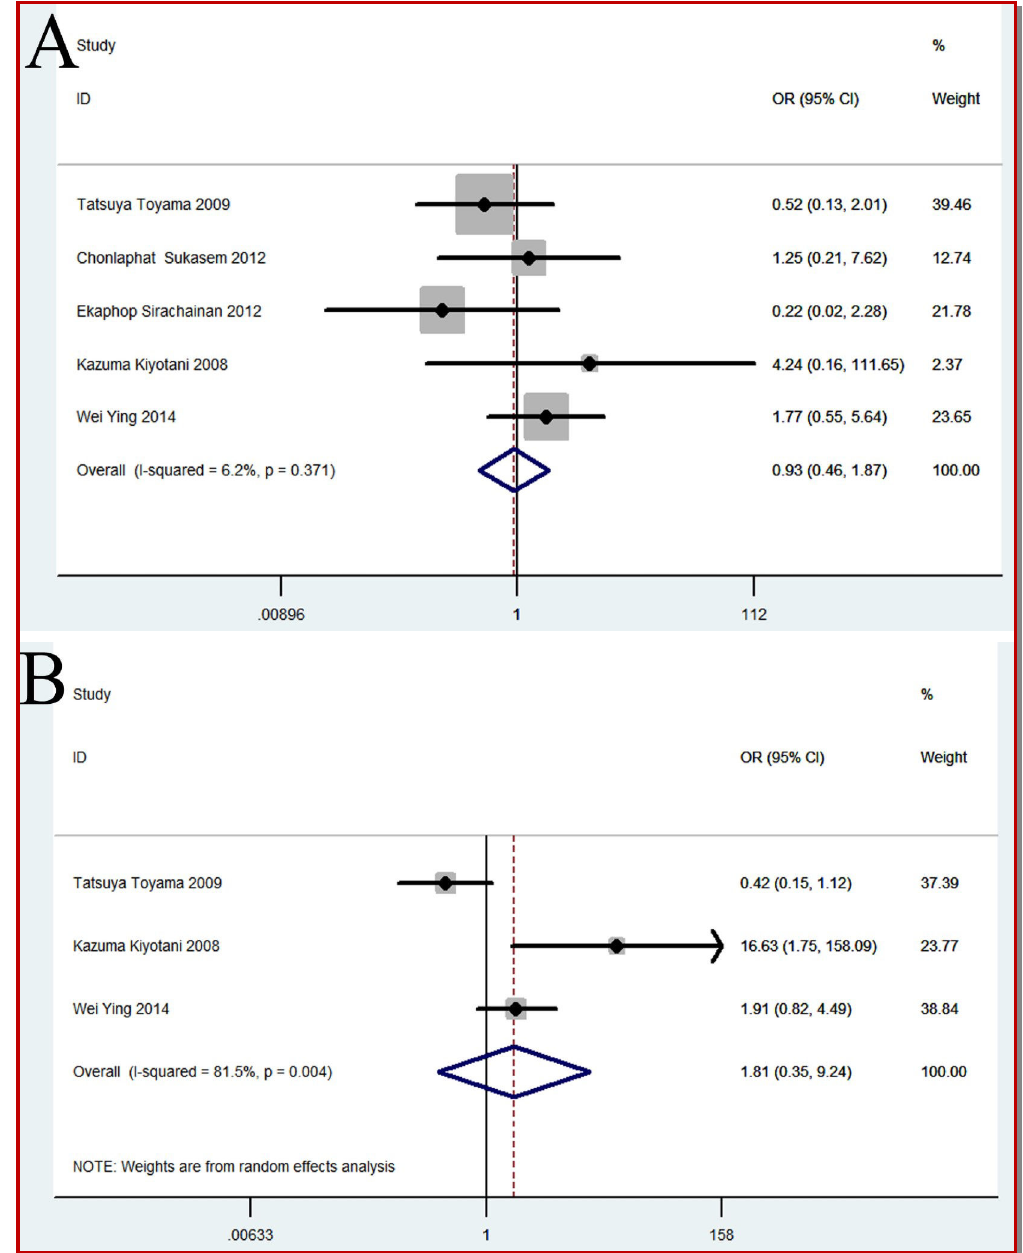
Figure 4: Meta-analysis for DFS of CYP2D6 Wt/Wt vs *10/*10. (A): 5 years-DFS; (B): 10